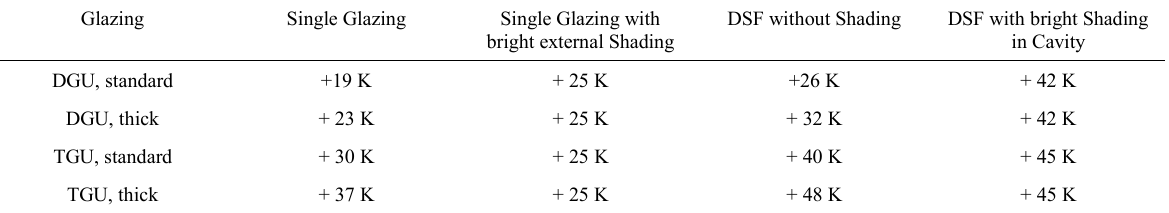
Table 3: IGU Climate Load Temperatures (ΔT) Summer Cases for standard IGU’s (DGU 4/16/4 with LowE Pos. 3 and TGU 4/14/4/14/4 LowE Pos. 2 & 5) and “thick” IGU’s (DGU 8/16/8 with LowE Pos. 3 and TGU 6/14/8/14/6 LowE Pos. 2 & 5) Glazing Single Glazing Single Glazing with DSF with bright Shading bright external Shading in